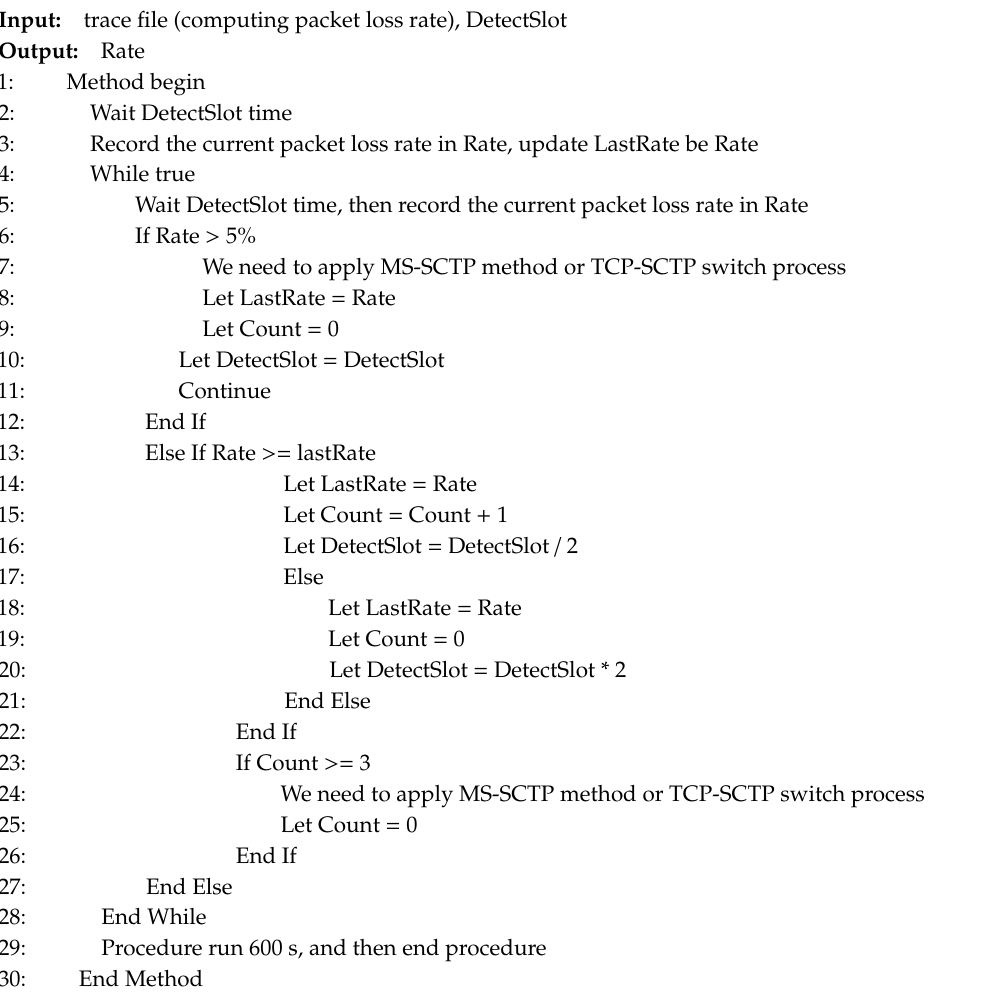
Algorithm 3. TCP-SCTP